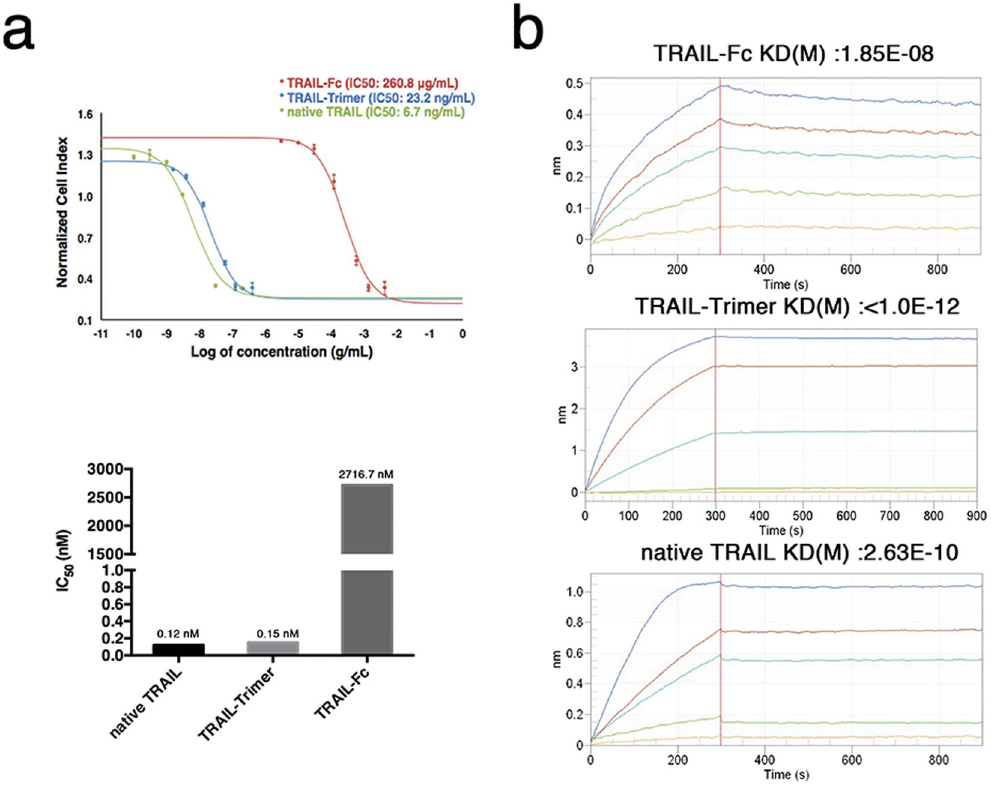
Figure 4. Bioactivity and affinity with DR5-Fc comparison of TRAIL-Trimer, TRAIL-Fc and native TRAIL. ( a ) Bioactivity detection of TRAIL-Trimer, TRAIL-Fc and native TRAIL. The IC 50 value of TRAIL-Trimer, TRAIL-Fc and native TRAIL were assessed using a TRAIL sensitive cell line COLO205 on a Real-Time Cell Analysis (RTCA) system. The IC 50 value was obtained according to the dose-response cell index (CI) curve. The IC 50 value of TRAIL-Trimer, TRAIL-Fc and native TRAIL is 23.2 ng/mL, 260.8 µ g/mL, and 6.7 ng/mL, respectively. The bottom graph displays IC 50 values when molar ratio-adjusted based on theoretical molecular weights for each protein. ( b ) Kinetic parameters of TRAIL-Trimer, TRAIL-Fc and native TRAIL binding to the soluble DR5-Fc fusion protein was assessed by biolayer interferometry measurements. The Super Streptavidin